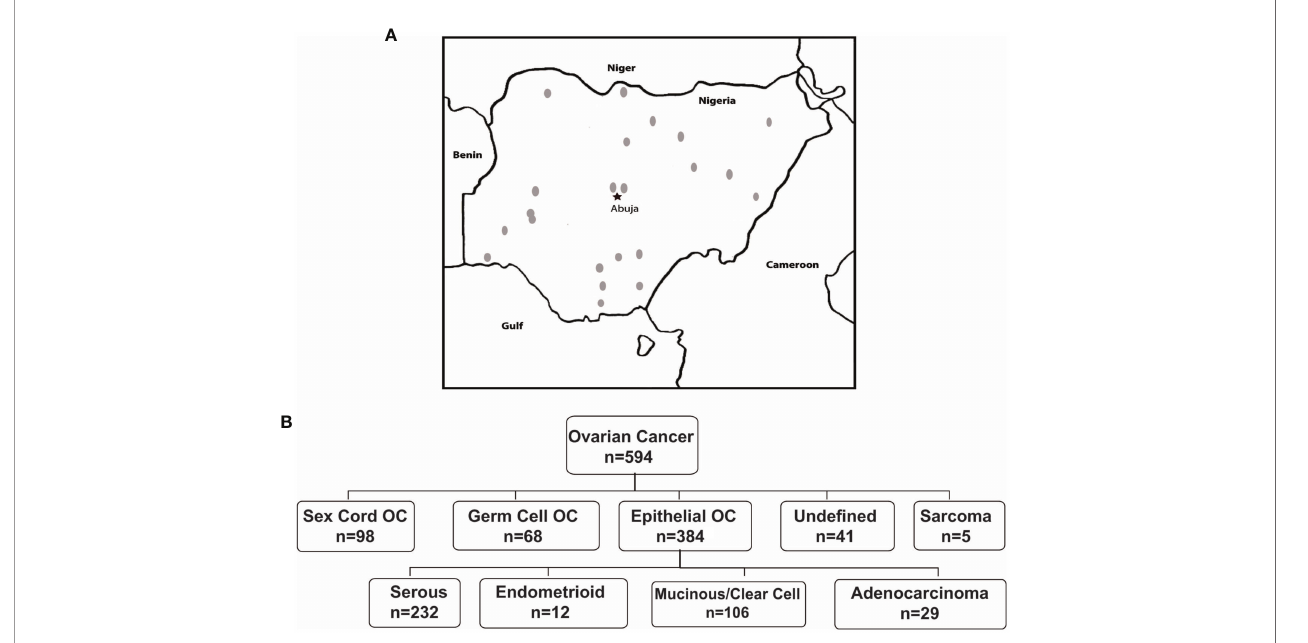
FIGURE 2 | (A) Study sites across Nigeria that participated in study. (B) Distribution of ovarian cancer cases by histology in